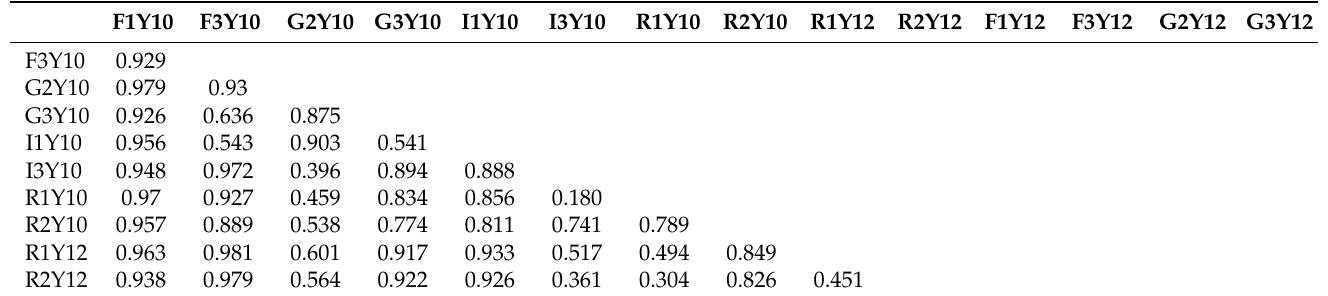
Table 4. Distance measures for non-metric multidimensional scaling. Final stress for 3-dimensional solution is 4.96131 and final instability is 0.00009 (F = Forest, G = Golf, I = Industrial, R = Residential; Y10 = 2010, Y12